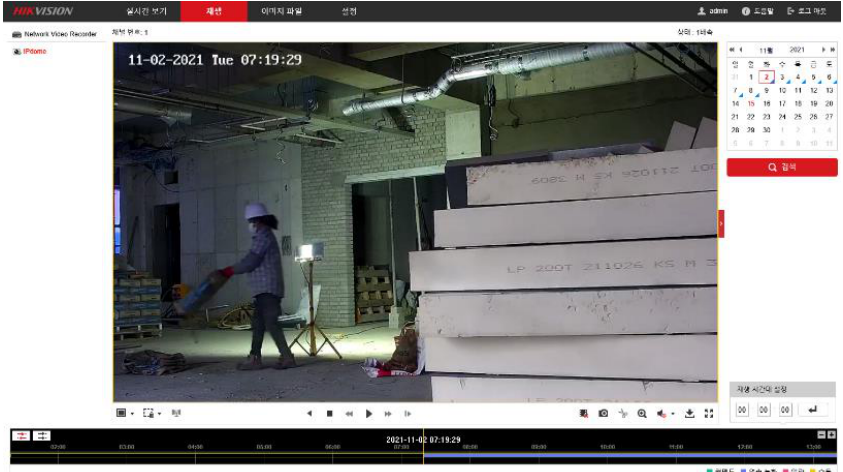
Figure 8. CCTV raw data.